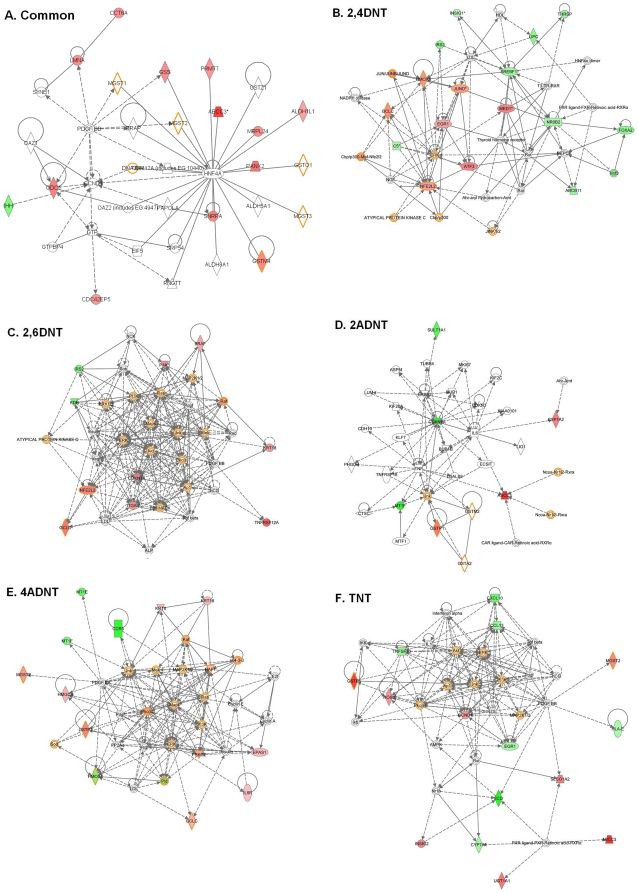
Common and specific gene networks related to liver toxicity induced by the compounds.The common gene network (A) was constructed using commonly significantly regulated genes by at least four of the compounds. For constructing specific gene networks related to liver toxicity of 2,4DNT(B), 2,6DNT(C), 2ADNT(D), 4ADNT(E) and TNT(F), only significantly regulated genes involved in known function to liver or hepatoxicity or liver diseases were selected for each compound. The red and green highlighted genes represent up-regulated and down-regulated genes respectively by one of the compound. The orange highlighted genes are involved in NRF2-mediated oxidative stress response. The up or down-regulated genes in the networks were determined by comparing the averaged treatments with relative controls of a compound. The gene networks were built using the Ingenuity knowledge base tool. The networks scores described in Materials and Methods for all the networks were bigger than 10.